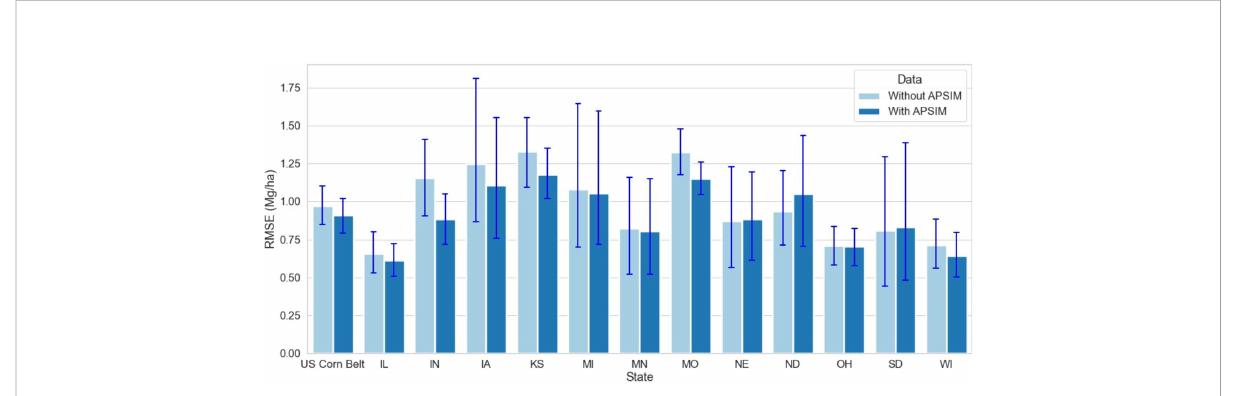
FIGURE 8 Model Performance with and without APSIM for the year 2020 for 12 states of the US Corn Belt. The blue lines demonstrate the range of RMSE with and without APSIM. The fi rst set of bars compares the model performance for the US Corn Belt, while the other set of bars compares the model performance at the state